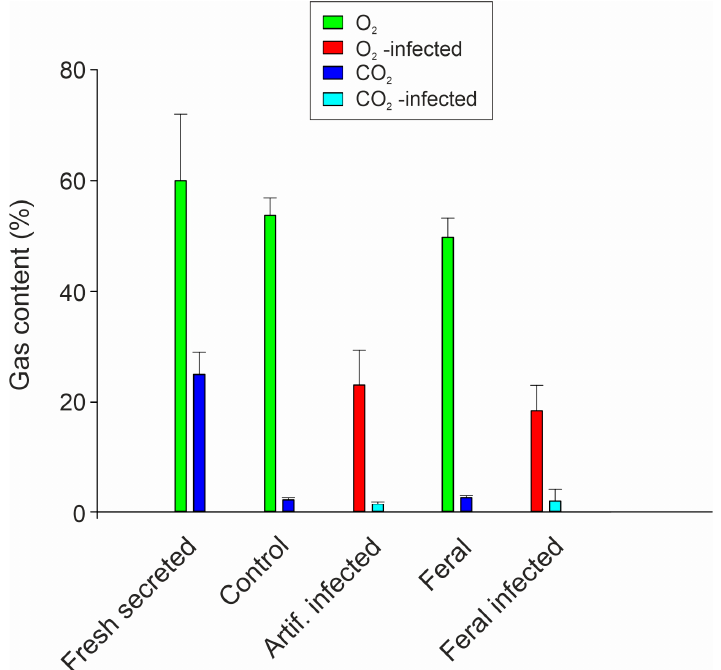
Figure 4. Oxygen and CO 2 content of healthy and infected eel swimbladder. Oxygen makes up the largest fraction of freshly secreted gas in the eel swimbladder, under steady-state conditions and in the swimbladder of feral eels collected in the wild. The fraction of CO 2 is also high in freshly secreted gas, but under steady-state conditions, it is much lower because of the preferential resorption due to the high physical solubility of CO 2 . In eels artificially infected with the nematode Anguillicola crassus and in feral eels with infected swimbladders, the oxygen content is largely reduced, and the CO 2 content is also reduced. Data from [67,77].